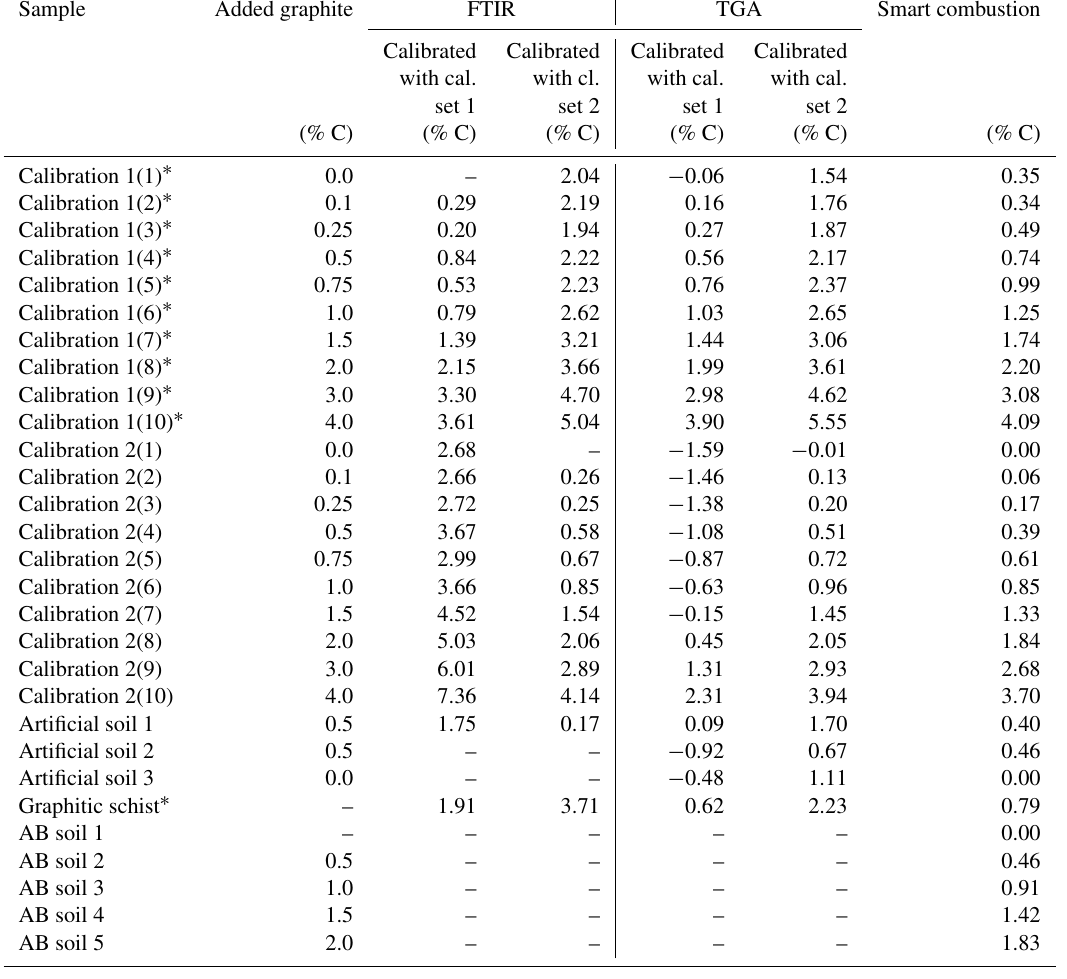
Table 2. Overview of the predicted graphitic carbon by the different examined methods. Sample Added